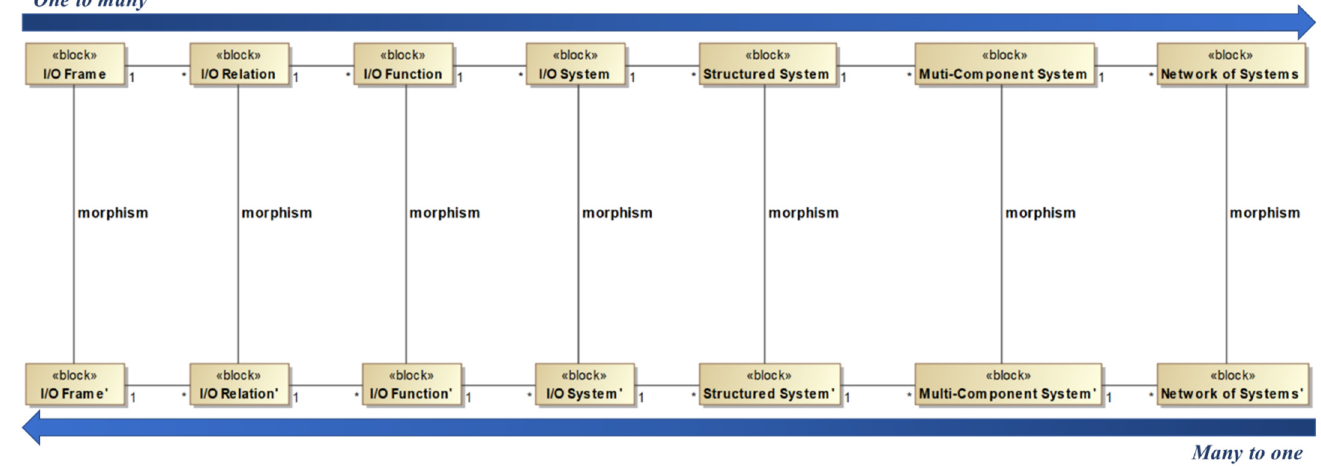
Figure 11. A visual representation of the hierarchy of system specifications shown in Table 1, corresponding association mappings and multiplicity (horizontal) between the levels, and associated morphisms (vertical) within levels [10].